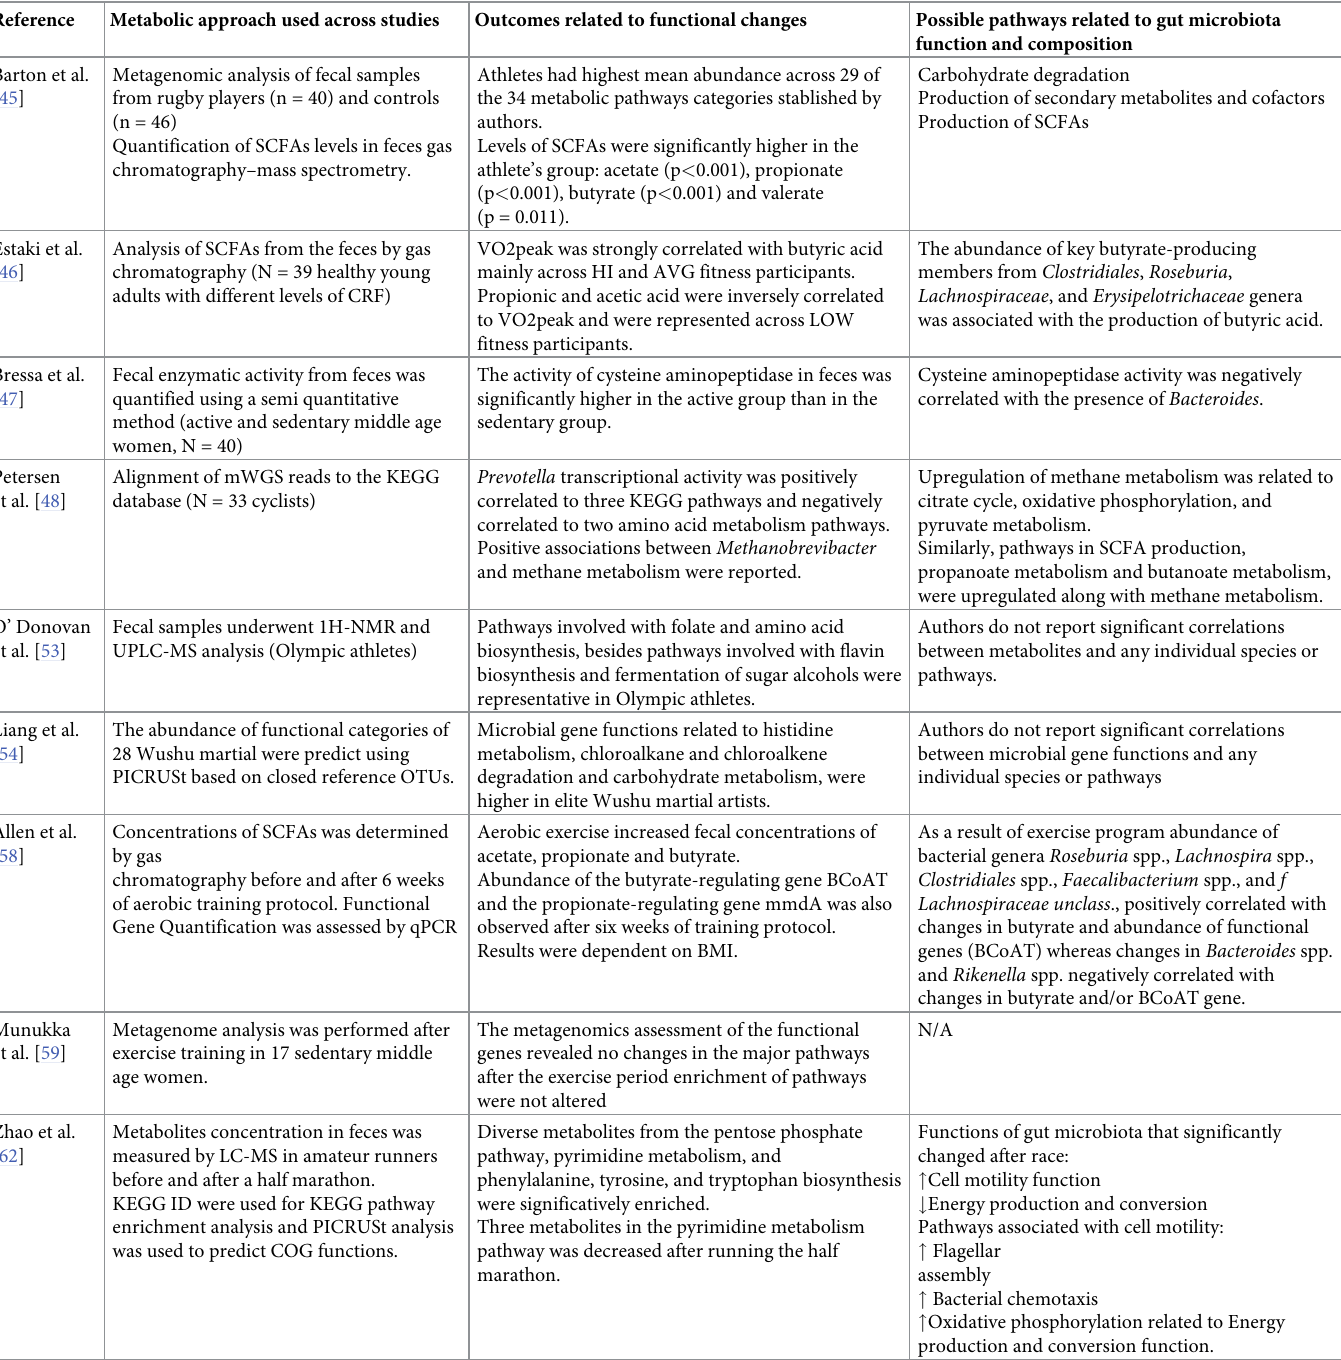
Table 3. Description of possible functional changes associated with gut microbiota in physical activity and sports